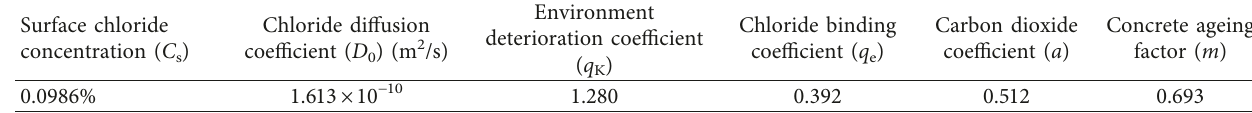
Table 5: Parameters of the modified chloride diffusion model by regression analysis.